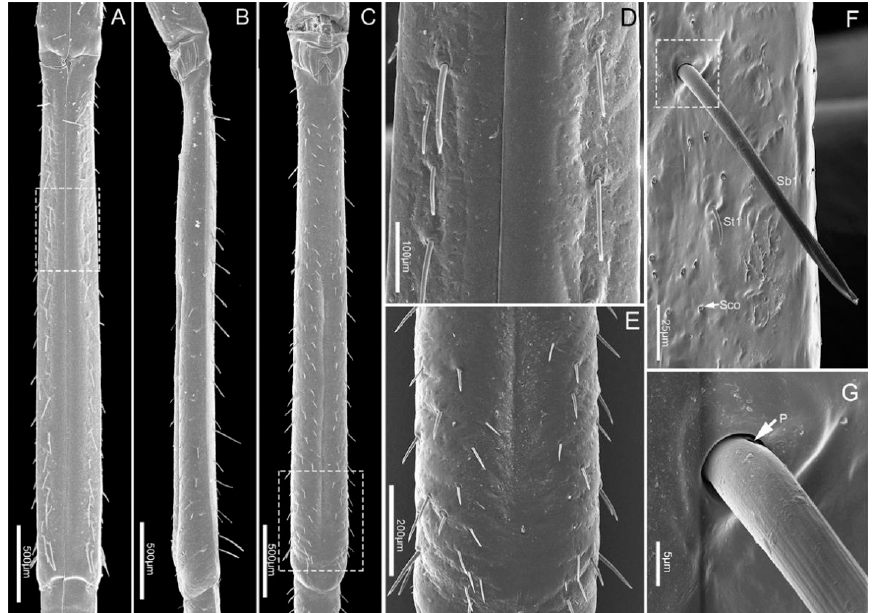
Figure 5. SEM of the third labial segment of E. fullo . ( A ) Ventral view; ( B ) Lateral view; ( C ) Dorsal view; ( D ) Enlarged view of outlined box of ( A ); ( E ) Enlarged view of outlined box of ( C ); ( F ) Enlarged view of surface of the third segment, showing sensilla basiconica 1 (Sb1), sensilla trichodea 1 (St1), and sensilla coeloconica (Sco); ( G ) Enlarged view of outlined box of ( F ), showing base pore (p).